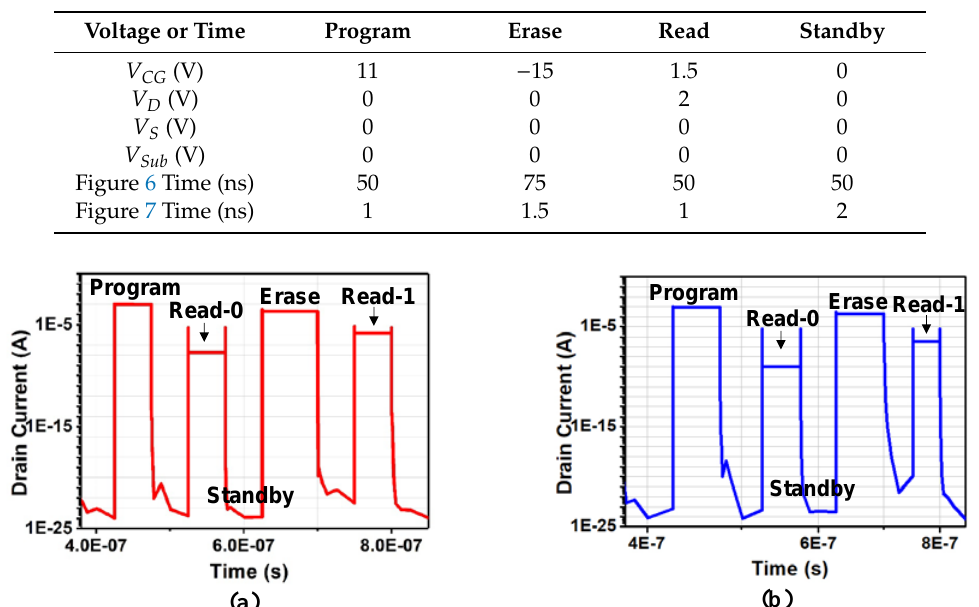
FG and ( b ) UFGM with FG with time in a + + 𝑝𝑝 𝑛𝑛